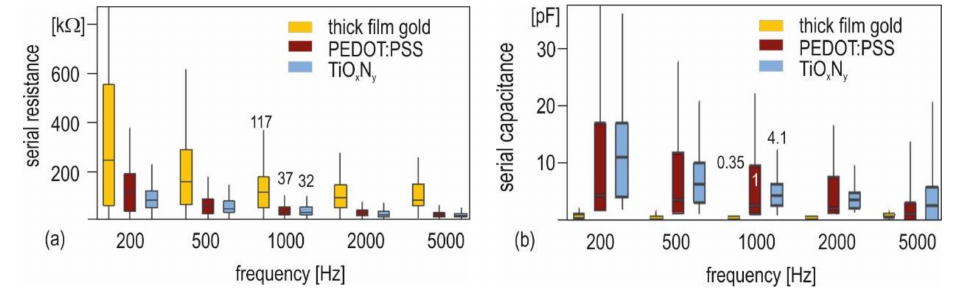
Figure 6. Serial equivalent circuit components as a function of the frequency; ( a ) serial resistance; ( b ) serial capacitance. Measurements on 86- µ m electrodes are compared, including thick film gold, MEA type C; PEDOT:PSS coating on thick film gold, MEA type A and TiO x N y coating on thick film gold, MEA type A.